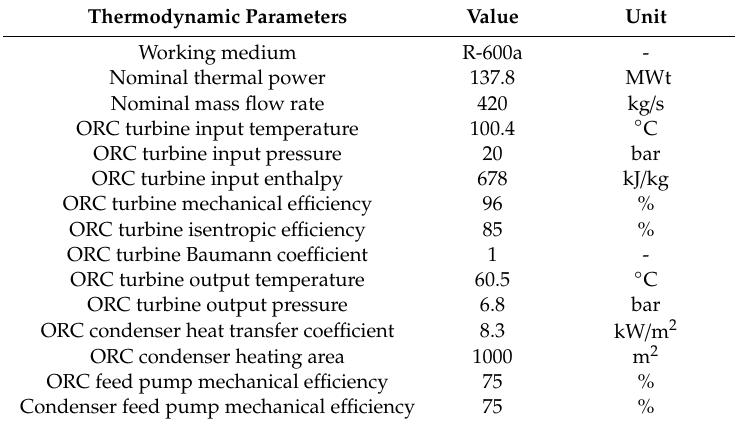
Figure 11. The model of one stage ORC turbine with working medium R-600a. Table 2. Nominal thermodynamic parameters of the model of the ORC.